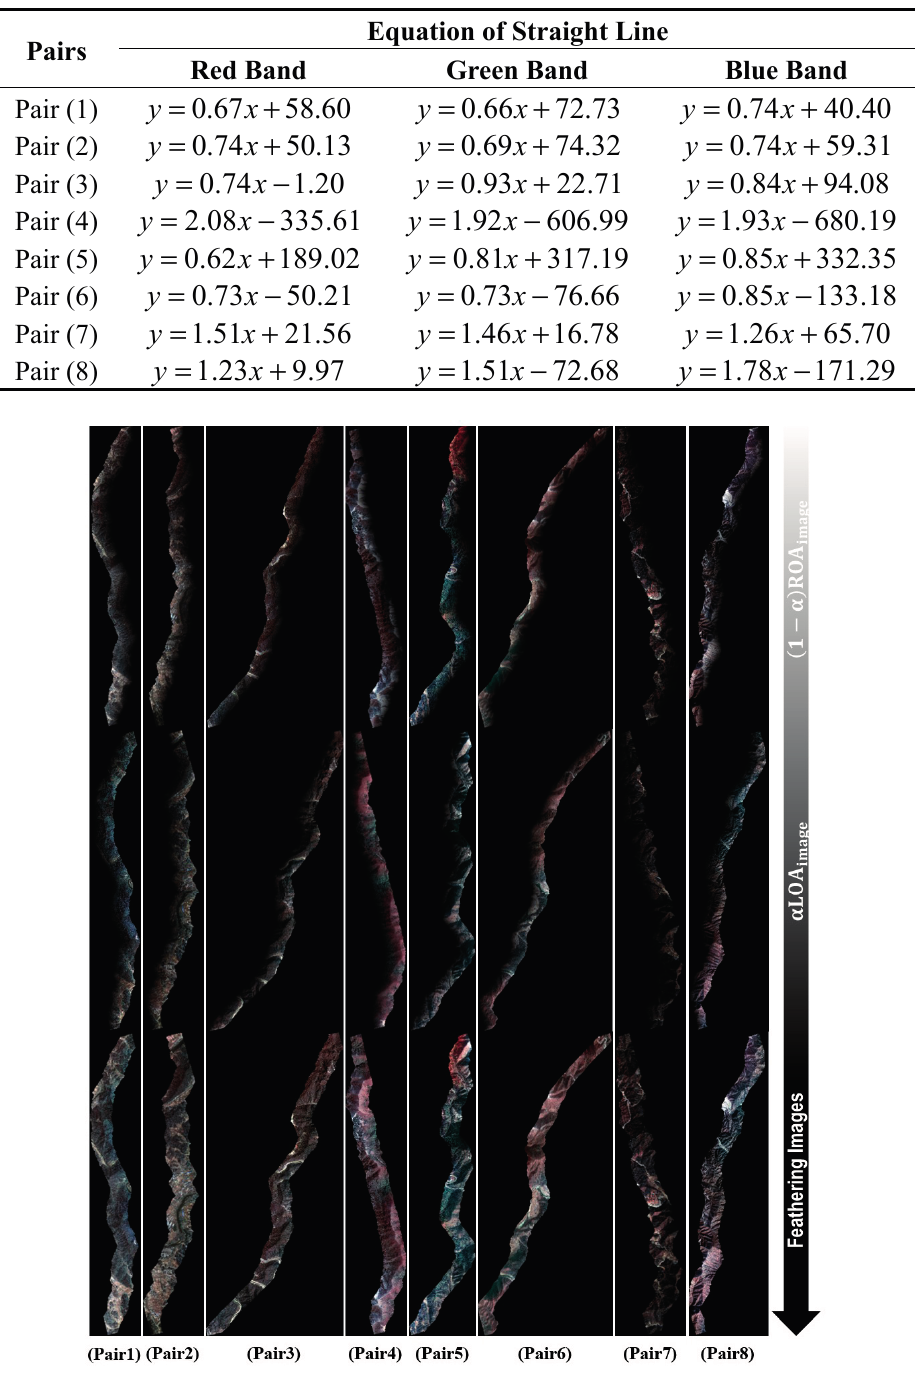
Table 4. Calculated Equations of the Straight Lines for the Matching Histogram.